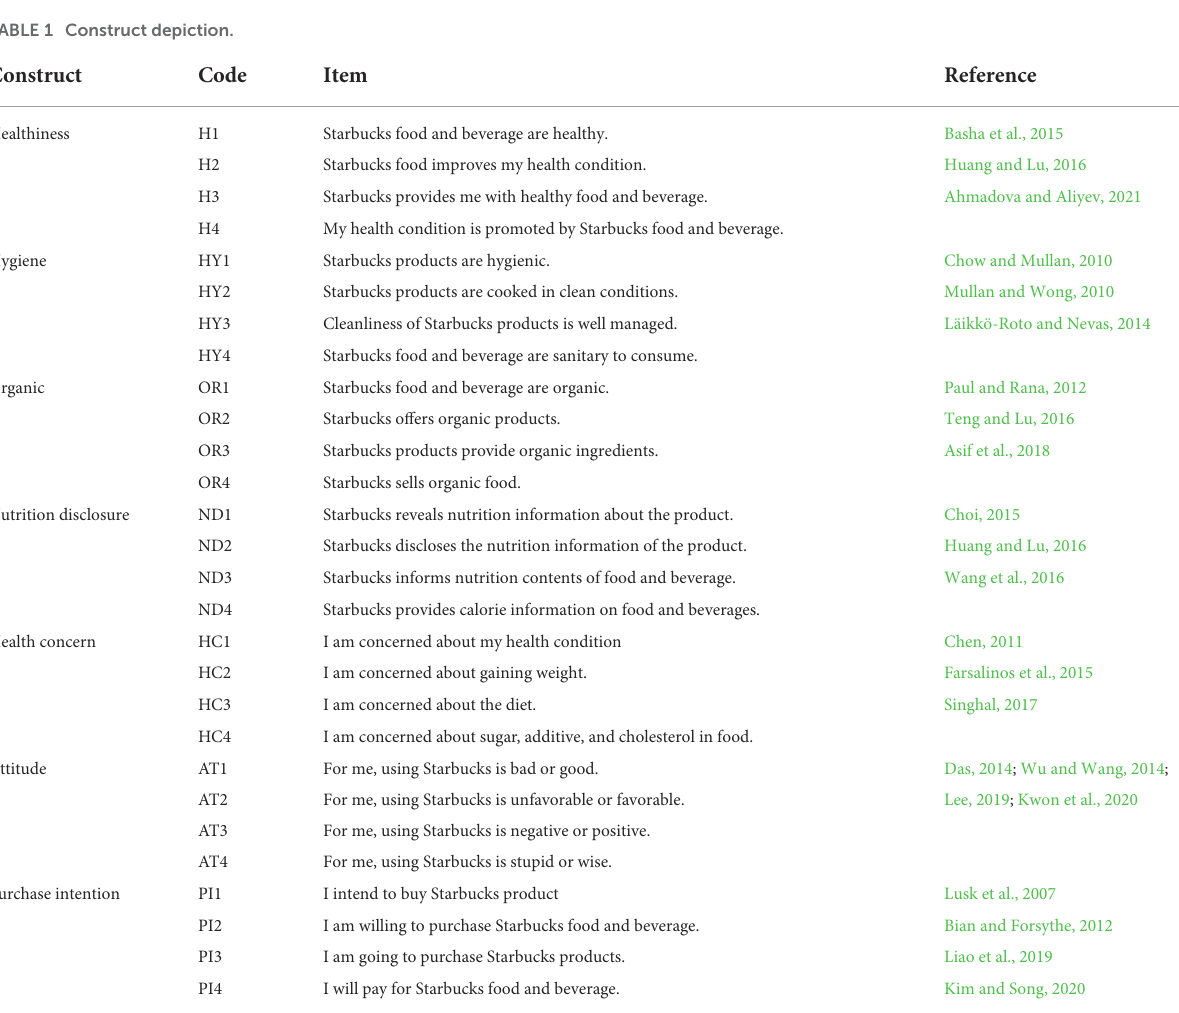
TABLE 1 Construct